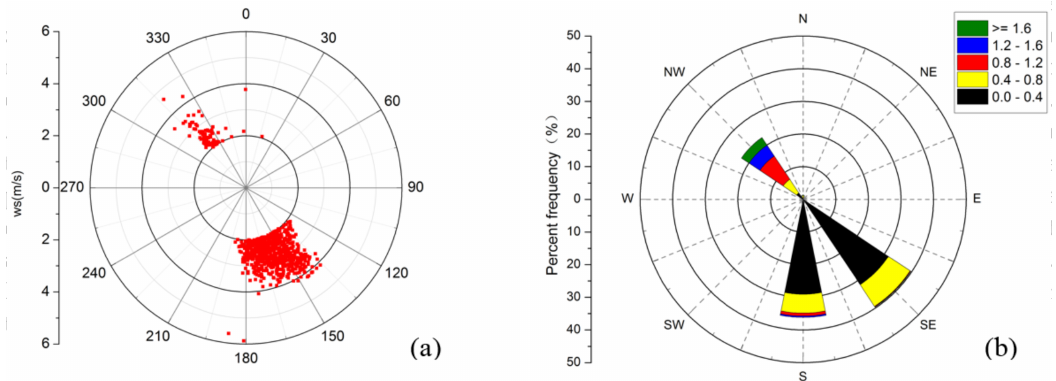
Figure 4. ( a ) Distribution map of half-hourly wind speed data and ( b ) half-hourly z 0m rose-binned data map at Arou station in August.